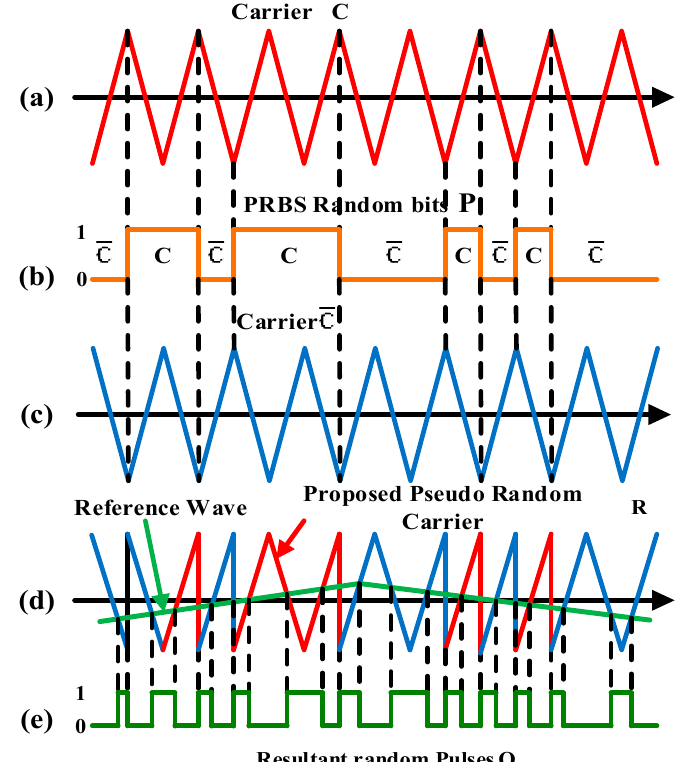
Figure 3. RPWM pulse arrangement. ( a ). Carrier signal and reference signals, ( b ). PRBS random bit, ( c ) Invented Carrier signal and reference signal, ( d ). Mixed multi frequency carrier and reference signal, ( e ). Resultant random pulses